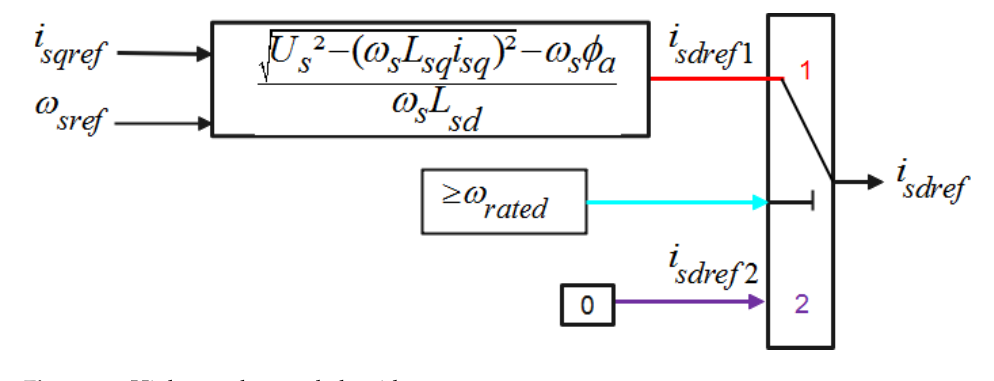
Figure 10. High-speed control algorithm.